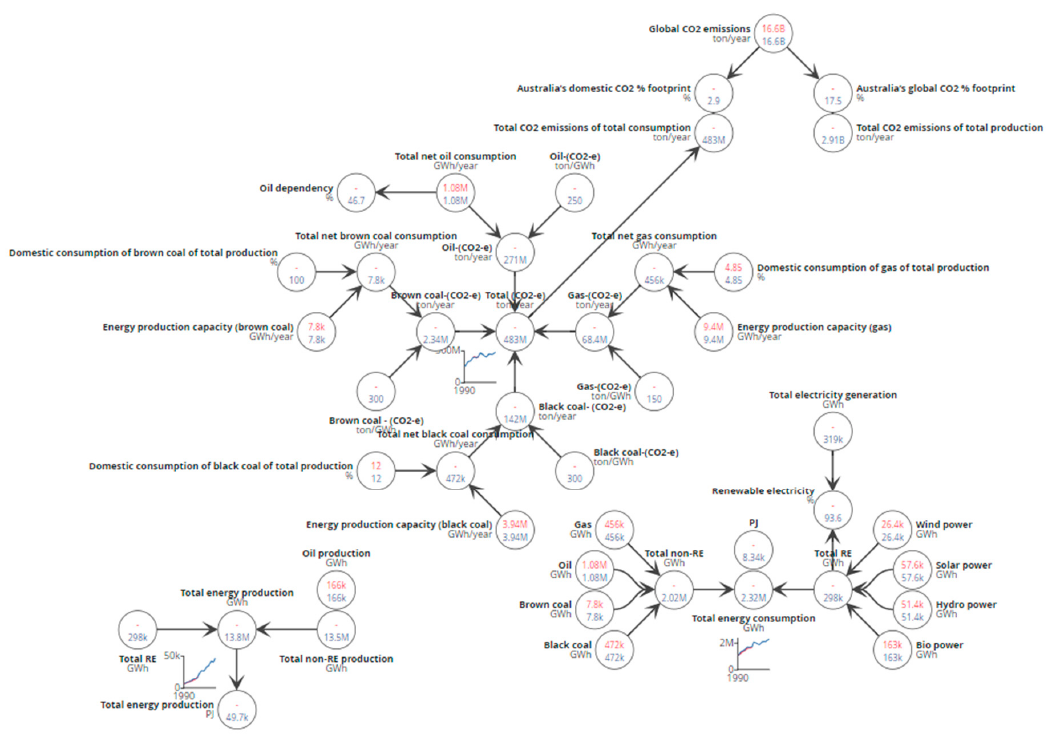
Figure 5. CO 2 emissions model.